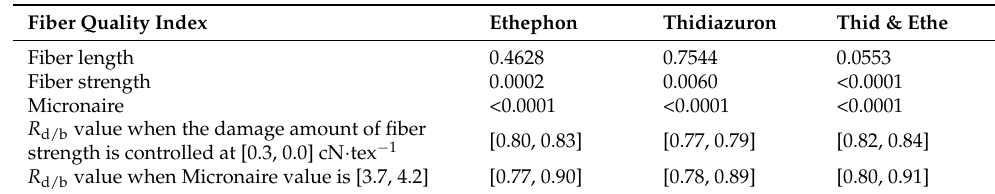
Table 6. Variance analysis of the fiber quality damage and R d/b value under different harvest aid treatments and the appropriate R d/b value.